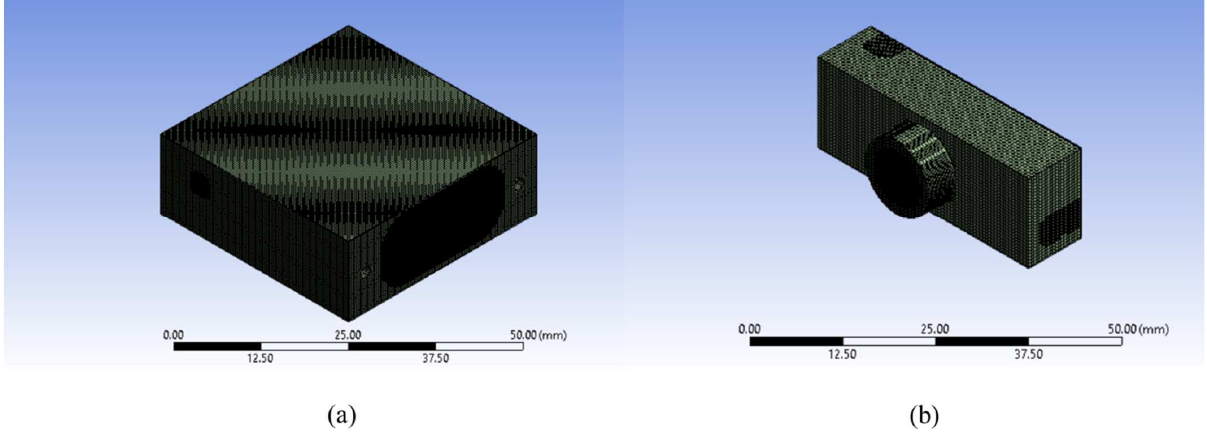
Figure 4. The numerical simulation mesh ( a ) horizontal vortex combustor and ( b ) vertical vortex combustor.